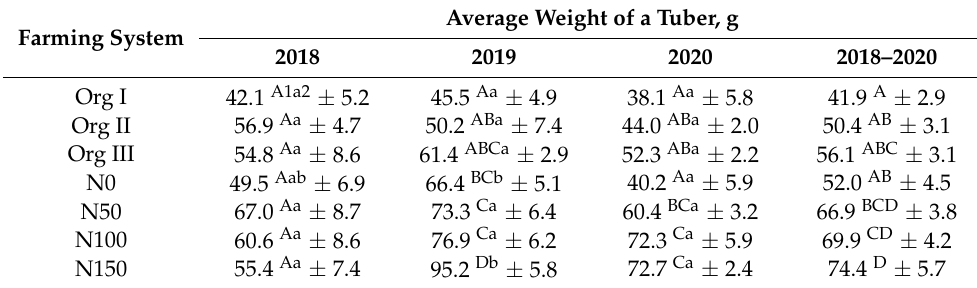
Table 5. Average weight of a tuber depending on the farming system. Farming